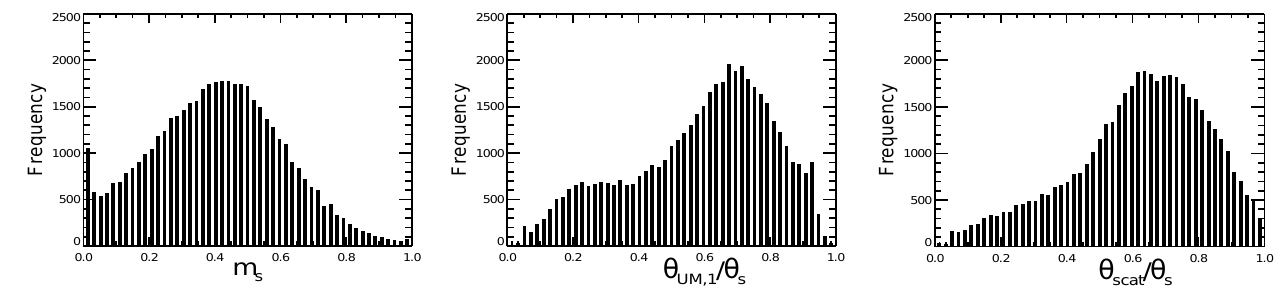
Fig. 3. Histograms of ASCAT surface soil wetness m s , UM level 1 soil wetness θ UM , 1 /θ s and converted ASCAT soil wetness θ scat /θ s . Data is for the NW Europe region, 15 ◦ W to 15 ◦ E; 37 ◦ N to 60 ◦ N and time period May to July